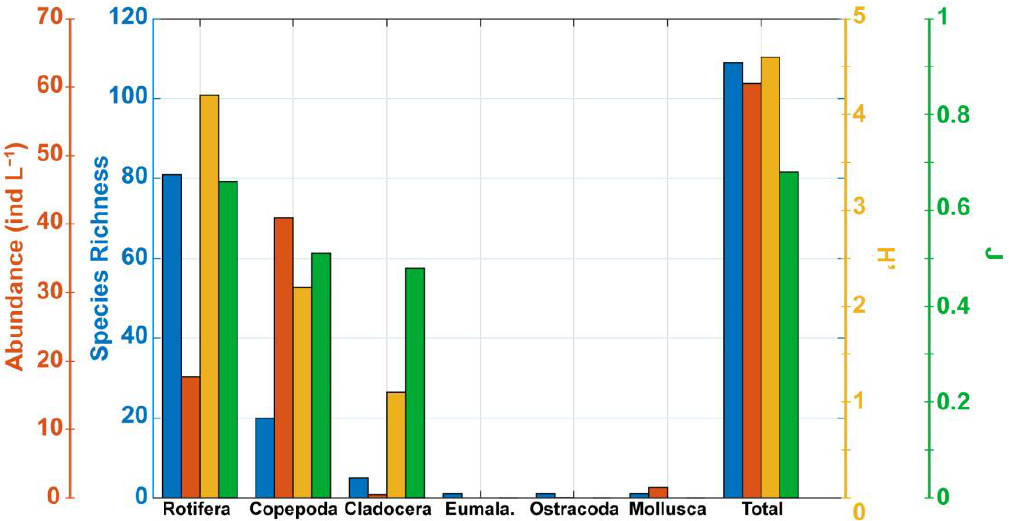
Figure 3. Overall species richness (blue), mean abundance (red), Shannon species diversity index (H’, yellow) and Piélou equitability index (J, green) for each of the zooplankton groups (Rotifera, Copepoda, Cladocera, Eumalacostraca, Ostracoda, Mollusca) as well as for the entire zooplankton community (Total).